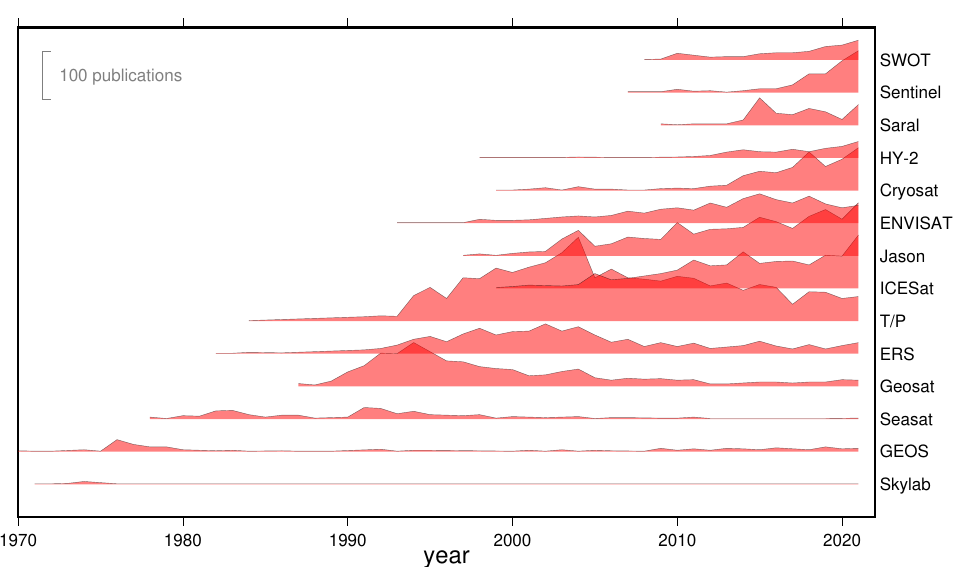
Figure 12. The number of annual publication related to the specific satellite altimetry missions. Note that the “Y-axis” label refers to a collection of specific satellite missions, such as HY-2, which includes HY-